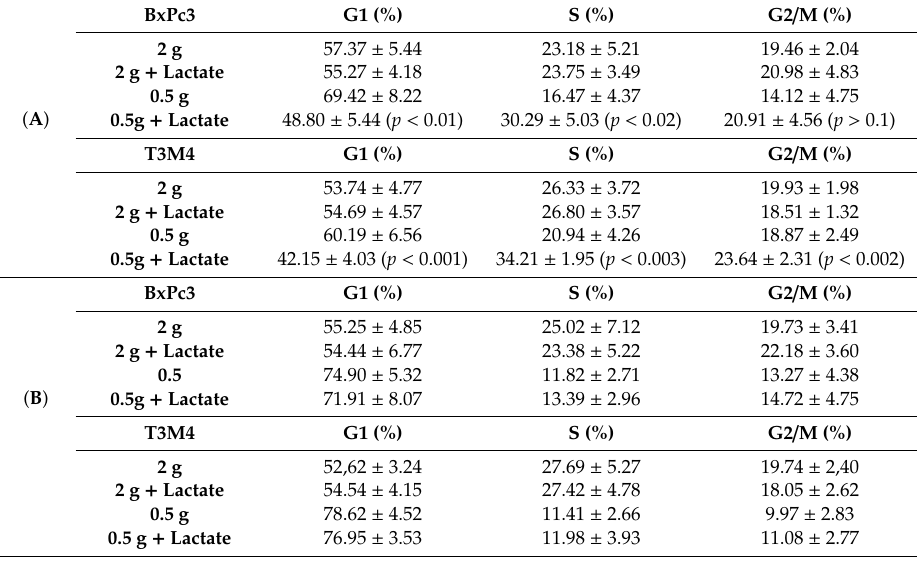
Table 1. Preculture under glucose restriction plus lactate primes BxPc3 and T3M4 cells for accelerated cell cycle upon reseeding in normal medium. Both BxPc3 and T3M4 were precultured for 72h in normal medium containing 2 g / L glucose without (2 g) or with 20 mM lactate (2 g + L) or in low glucose medium either without (0.5 g) or with 20 mM lactate (0.5 g + L). Then, cells were reseeded in